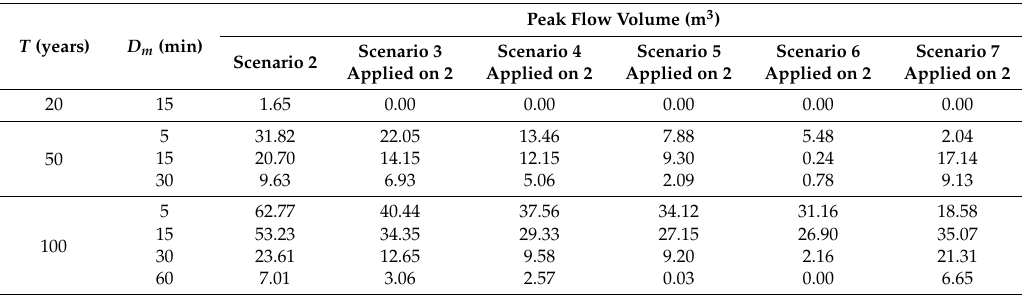
Table 10. Peak flow volumes based on the Scenario 2, recorded in the area that drains to the exit discharge point OF-1.